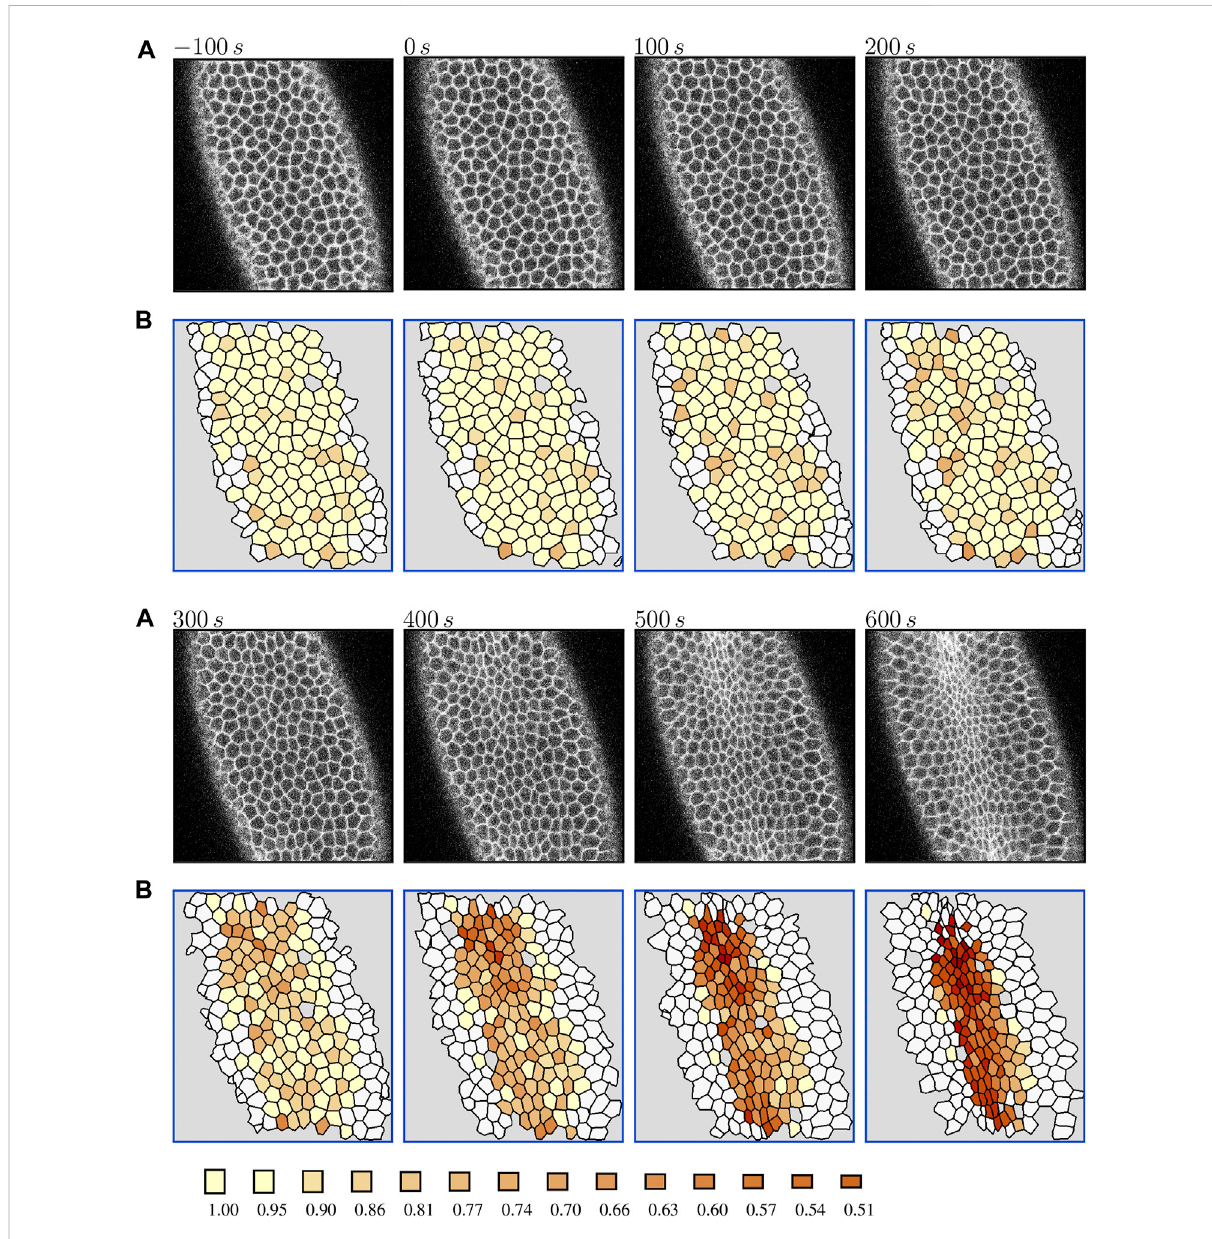
FIGURE 1 Evolution of overall cell apical constrictionpatterns in the Drosophila embryo during the slow phaseof VFF. (A) The original contrast-enhanced time-lapse images of the ventral side of a live Spider-GFP Drosophila embryo at the time (as labeled) measured from the onset of the ratcheted constrictionprocess. (B) Thecorrespondingprocessedimageswithtrackedcellscoloredbythevalueofareareductionfactor r A =0.95 k ,where k =0, 2, 3, ... (color bar); untracked cells are indicated in white, and areas not identi fi ed as cells by the image processing software are marked in gray. Time zero is set at the onset of the ratcheted constriction phase. The color scale is truncated at k = 2 because of the data resolution. The results for Embryo 1. Live embryo images were acquired previously [2] and are used here under the article ’ s CC BY